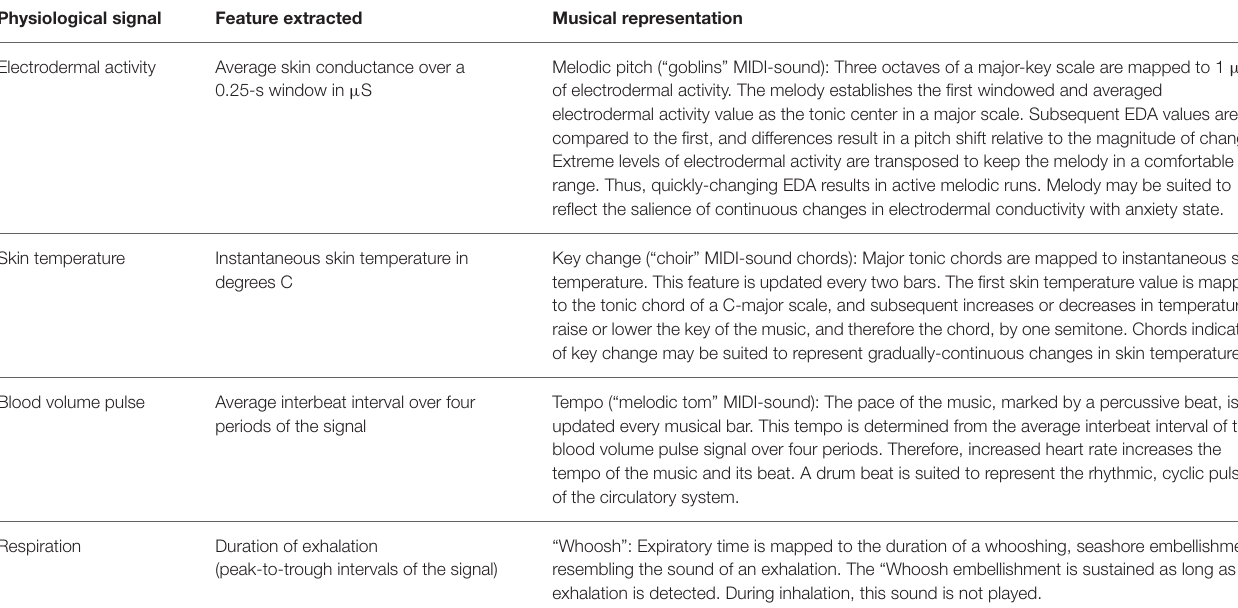
TABLE 1 | Physiological Signal-to-Music Mapping. Physiological signal Feature extracted Musical